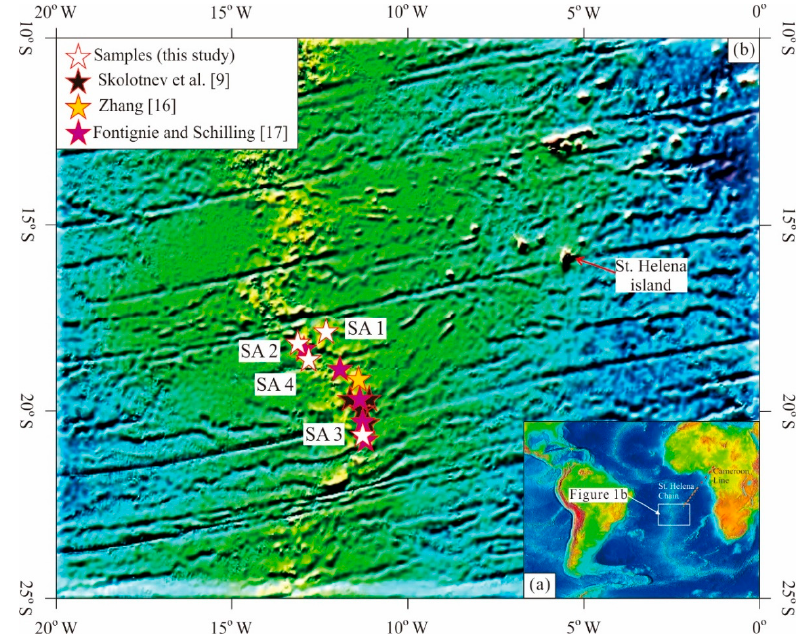
Figure 1. Map of the South Atlantic Mid-Ocean Ridge showing the dredged locations of the basalts analyzed in this study (map taken from [25]). ( a ) Map of the Atlantic Mid-Ocean Ridge showing the study area, ( b ) Sample location map.